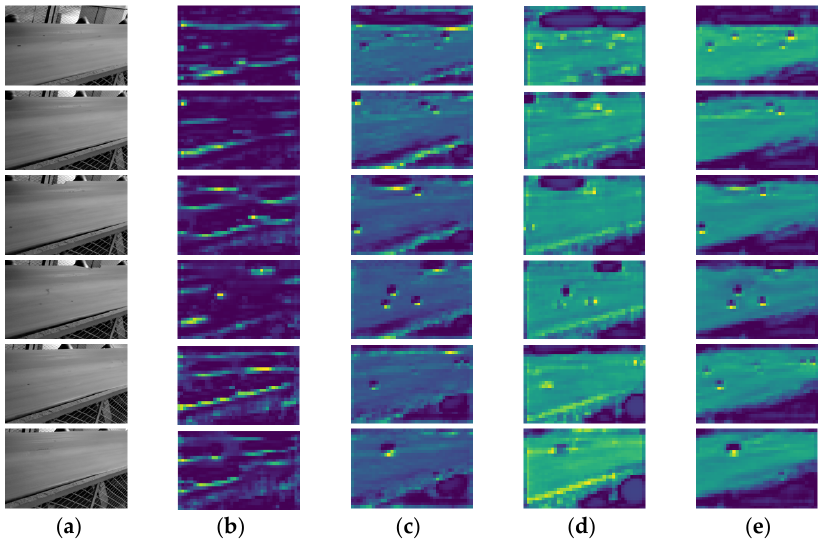
Figure 11. Comparison of output feature maps of different network detection heads. ( a ) Initial input images. ( b ) Feature map of YOLOv5m. ( c ) Feature map of YOLOv5n. ( d ) Feature map of YOLOv5n(KD). ( e ) Feature map of YOLOv5n-slim(KD).